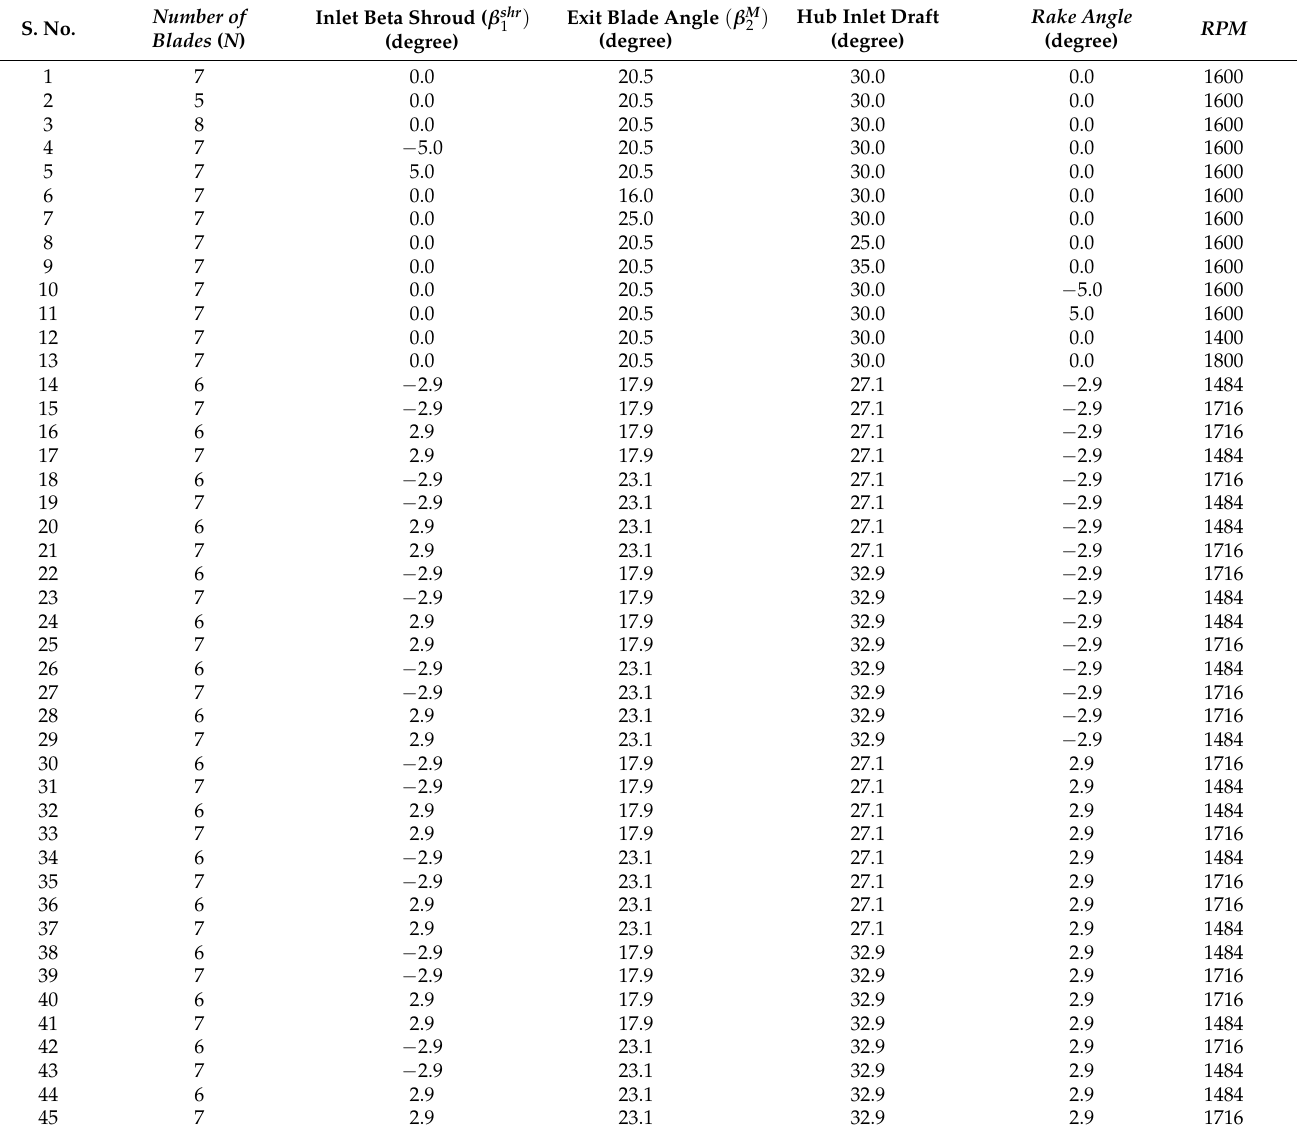
Table 4. Design of experiment using central composite design (CCD).